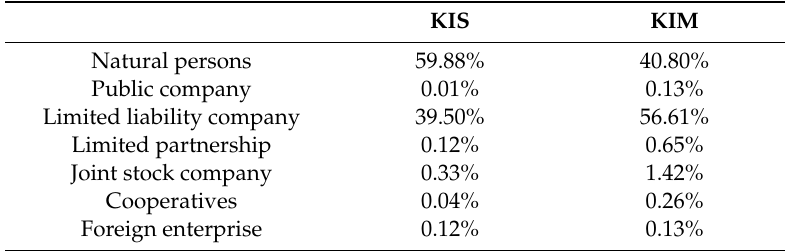
Table 1. Comparison of knowledge intensive manufacturers (KIM) and knowledge-intensive service providers (KIS) in terms of legal